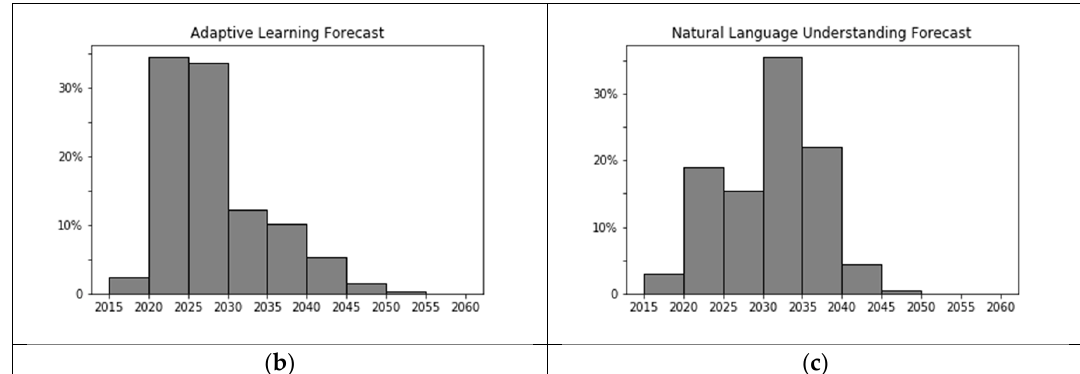
Figure 2. ( a ) A hypothetical judgmental distillation map is depicted. White ovals are inputs and light grey ovals are next generation (2nd order) technologies. General intelligence is depicted in a stacked fashion to indicate the possibility of future technological scenarios in the model to be realized through the combination of different paths (i.e., adheres to the holonic principle). The links in the figure are representative of causal relationships and the weights for these links correspond to the strength of these relationships. Note that this figure is not intended to be a forecast, but rather an example of what the JDM process could result in. Input distributions are randomly assigned using a normal distribution. Actual input distributions would not be based on a normal distribution and would be aggregated from expert opinion rather than parameterized distributions. ( b ) A histogram depicting the results of a Monte Carlo simulation for the next generation adaptive learning technology. ( c ) A histogram depicting the results of a Monte Carlo simulation for the next generation natural language understanding (NLU) technology. (Monte Carlo simulation is used to generate the distributions found in 2b and 2c. A notebook for computing these distributions can be found here: www.github.com / rossgritz / research /